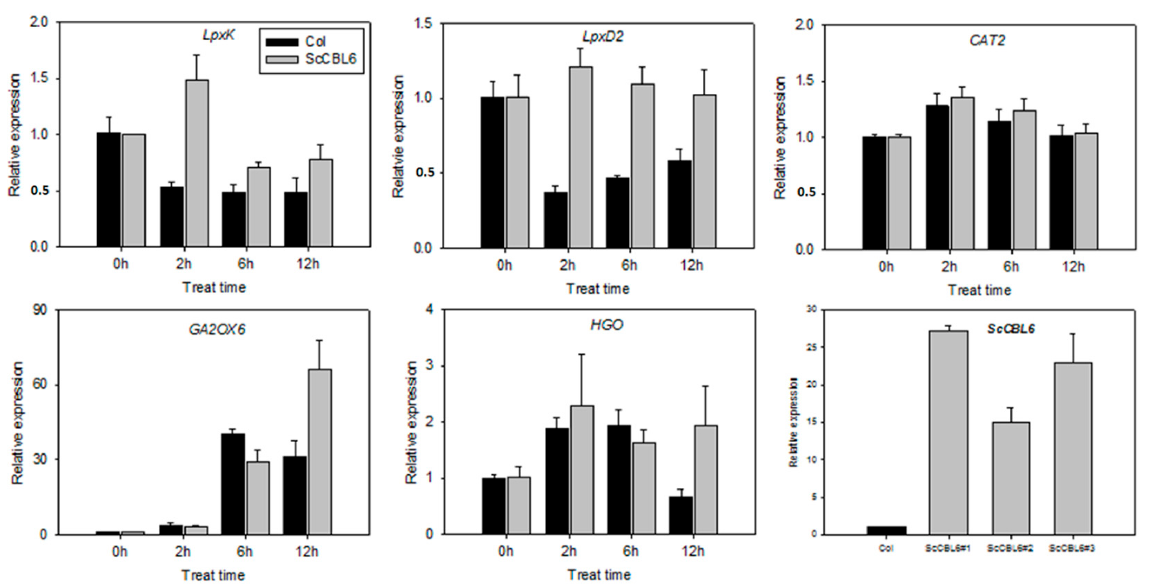
Figure 7. Quantitative reverse transcription-polymerase chain reaction analysis of candidate genes regulated by ScCBL6. The x-axis indicates the duration of cold stress; h, hour. Relative expression level calculated by the 2 − ∆∆ CT method relative to a non-cold-treated control for each cDNA.